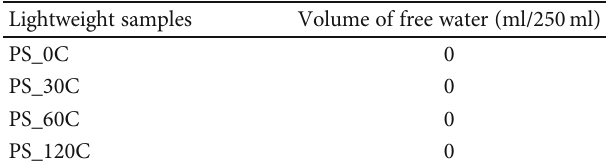
solution. 2 Table 4: Free water